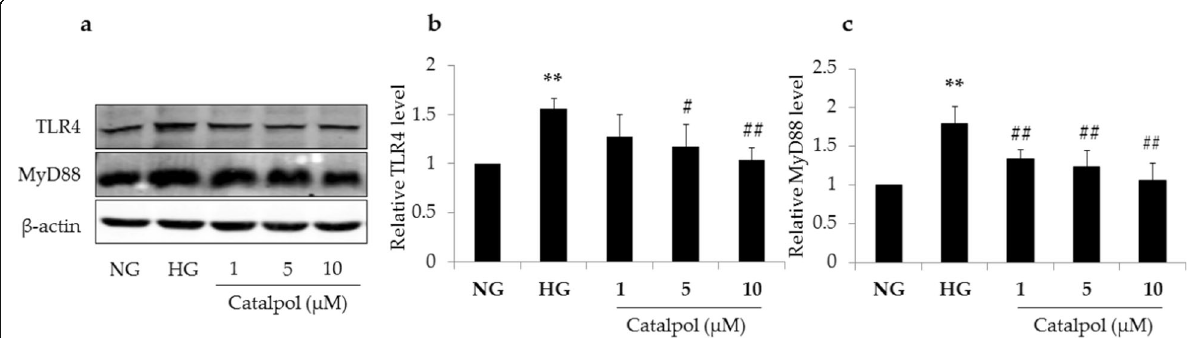
Fig. 6 Effect of catalpol on TLR4/MyD88 signaling pathway in HG-induced podocyte injury. a TLR4 and MyD88 detections in podocytes by western blotting. b The relative level of TLR4 to β -actin in podocytes ( n =3). c The relative level of MyD88 to β -actin in podocytes ( n =3). Data are expressed as the mean±SD. ** p <0.01 vs NG, # p <0.05, ## p <0.01 vs